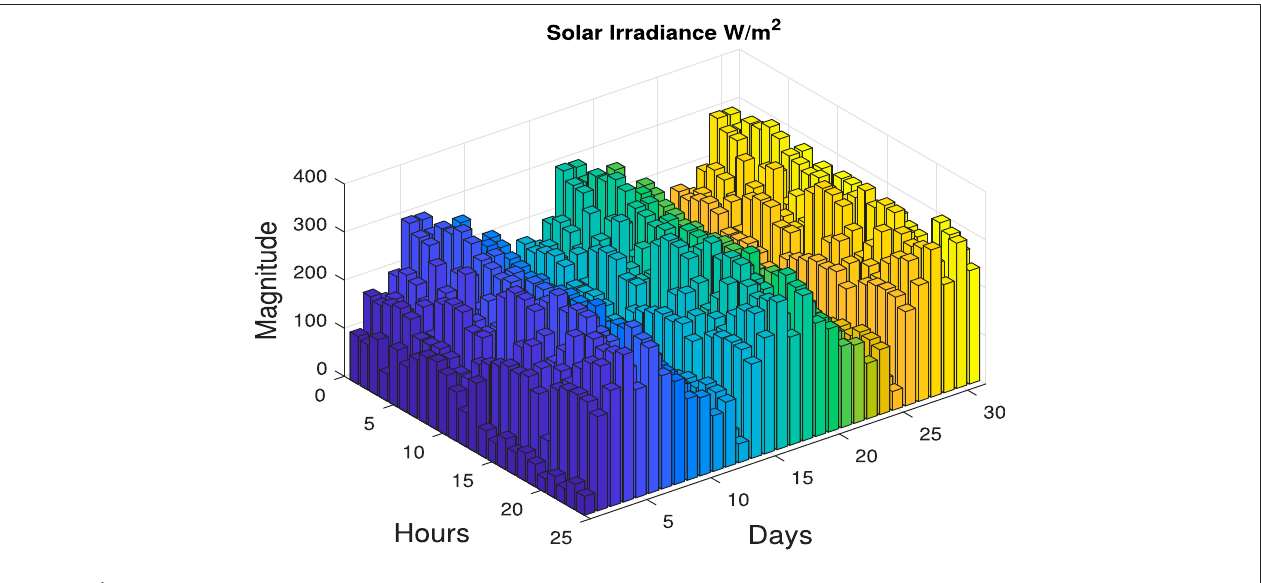
FIGURE 4 | Solar data in a 2D